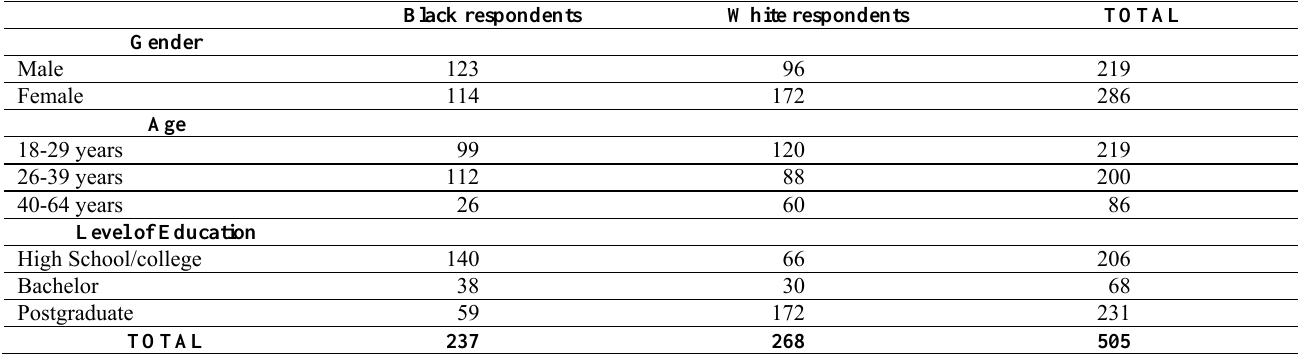
Table 1: Demographic information of the